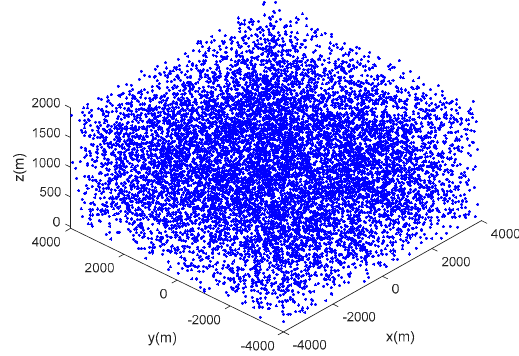
Figure 5. Target trajectories in scenario 2. Figure 6. The real measurements with clutter in scenario 2. For all of these scenarios, the detection probability